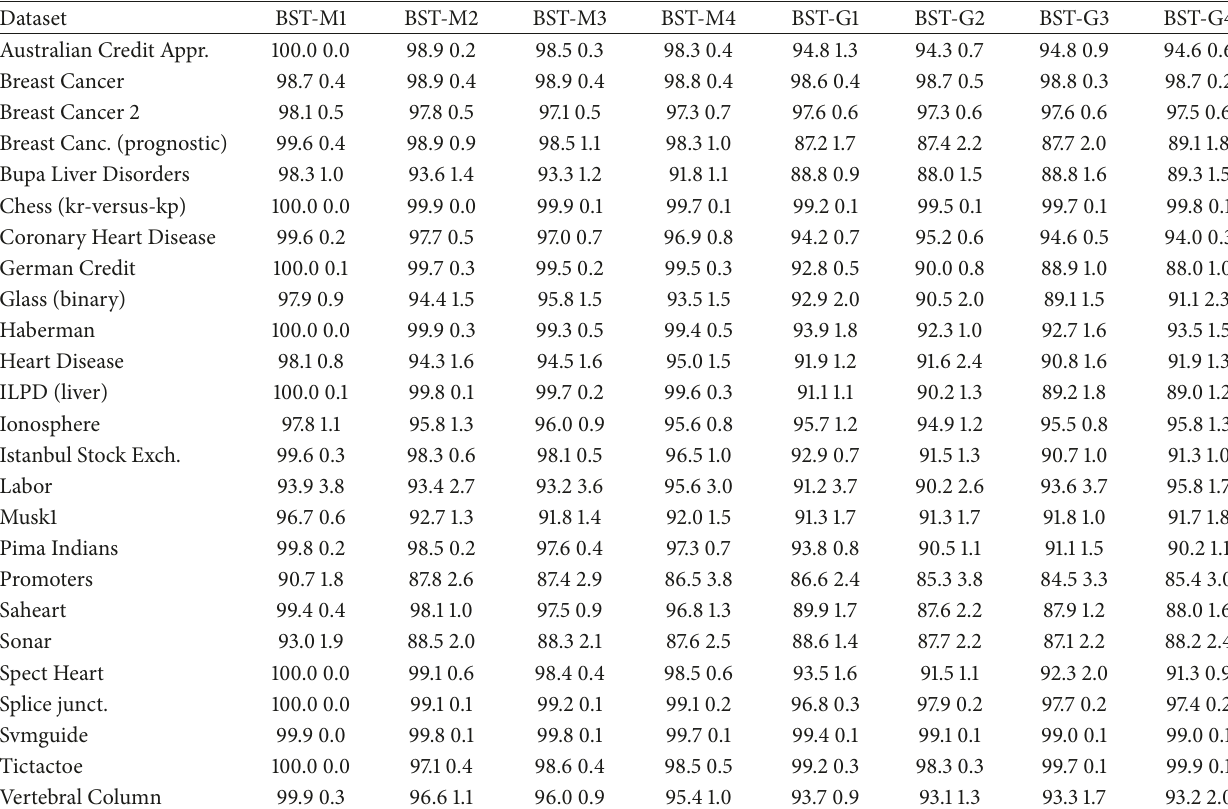
Table 8: Average fidelity and standard deviations of the extracted rules for BST-M and BST-G.